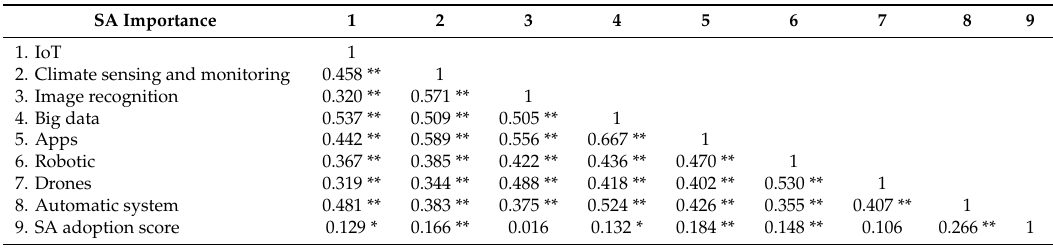
Table 4. Correlation matrix of the SA importance and adoption ( n =